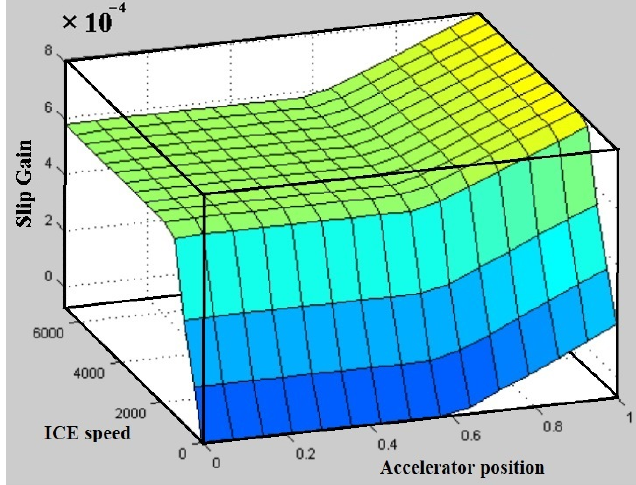
Figure 6. Slipping gain, ICE speed, and acceleration position.